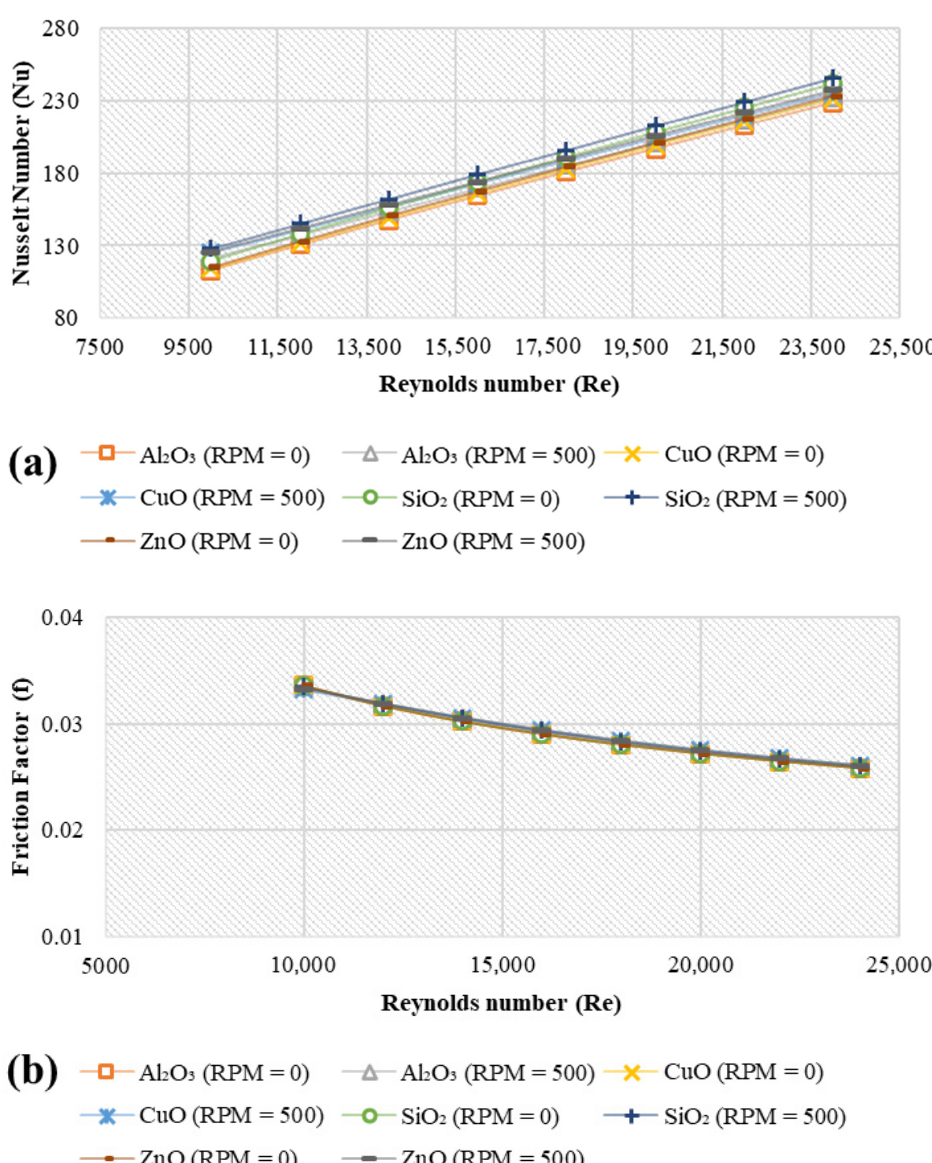
Figure 8. Variations of ( a ) average Nusselt number and ( b ) friction factor for different metal oxide nanostructures and different rotation speeds at 4 vol.%, 20 nm, and 293